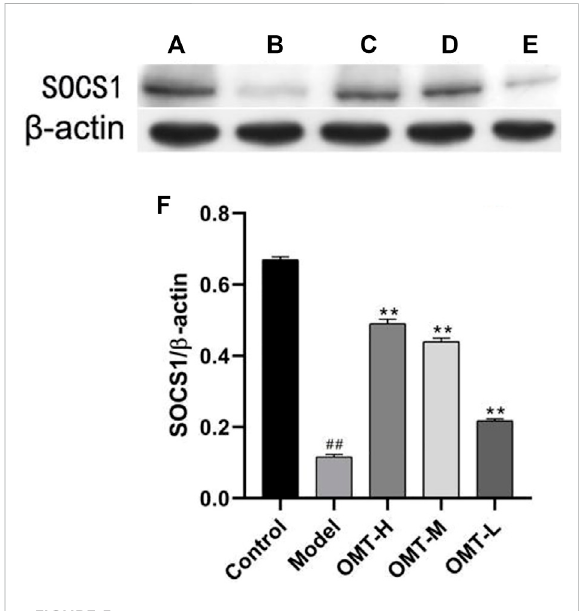
FIGURE 5 Expression of SOCS1 protein in skin tissue ( β -actin image for controlwerethesameinFigure5andFigure6). (A) Normalcontrol group; (B) Model group. (C) OMT-H group. (D) OMT-M group. (E) OMT-L group. (F) Statistical data of expression of SOCS1 protein in each group. ( ## , p < .01, vs. Control group; **, p < .01, vs. model